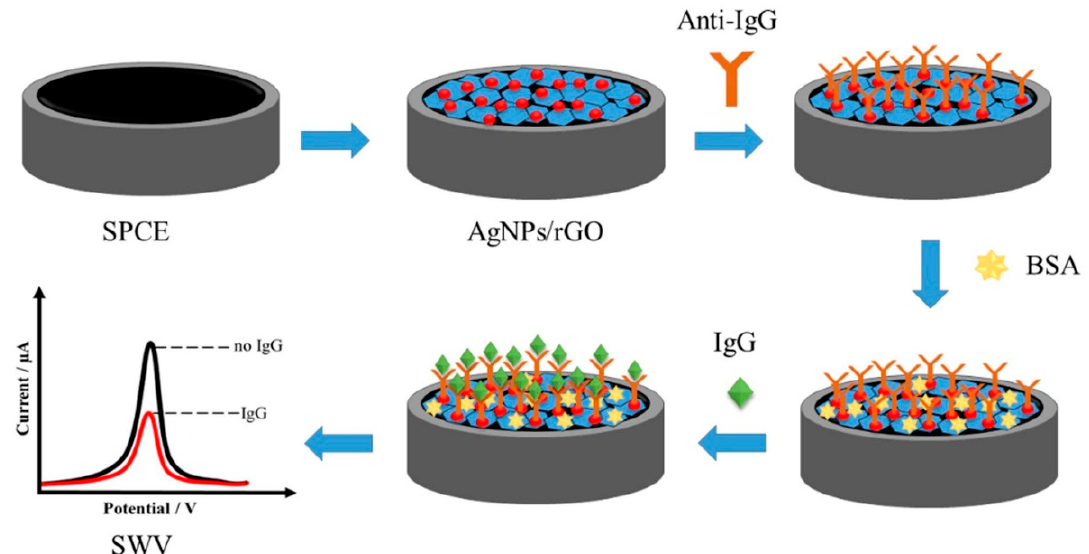
Figure 7. Electrochemical immunosensor for immunoglobulin G in blood serum. Screen-printed carbon electrodes are coated with AgNPs-reduced GO composites linked to antibodies specific for immunoglobulin G. Image adapted from [69] with permission of Frontiers, 2021.